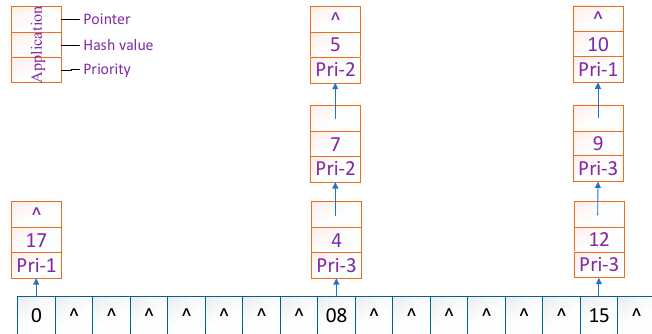
Figure 9. The priority-based storage structure in the DCH-based deploying algorithm.